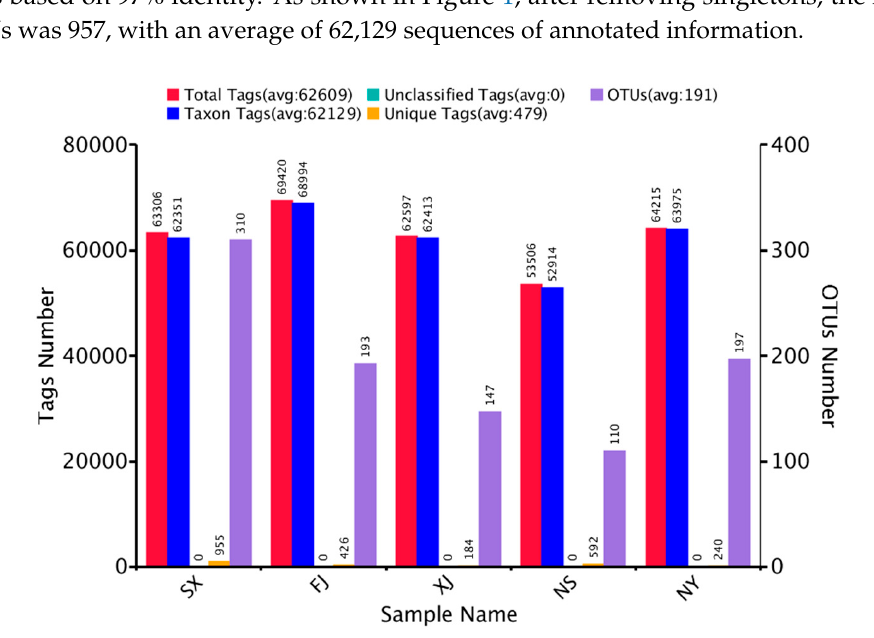
Figure 2. Relative abundance of the top 10 bacteria at the phylum level of taxonomy. The other phyla are included as “Others.”